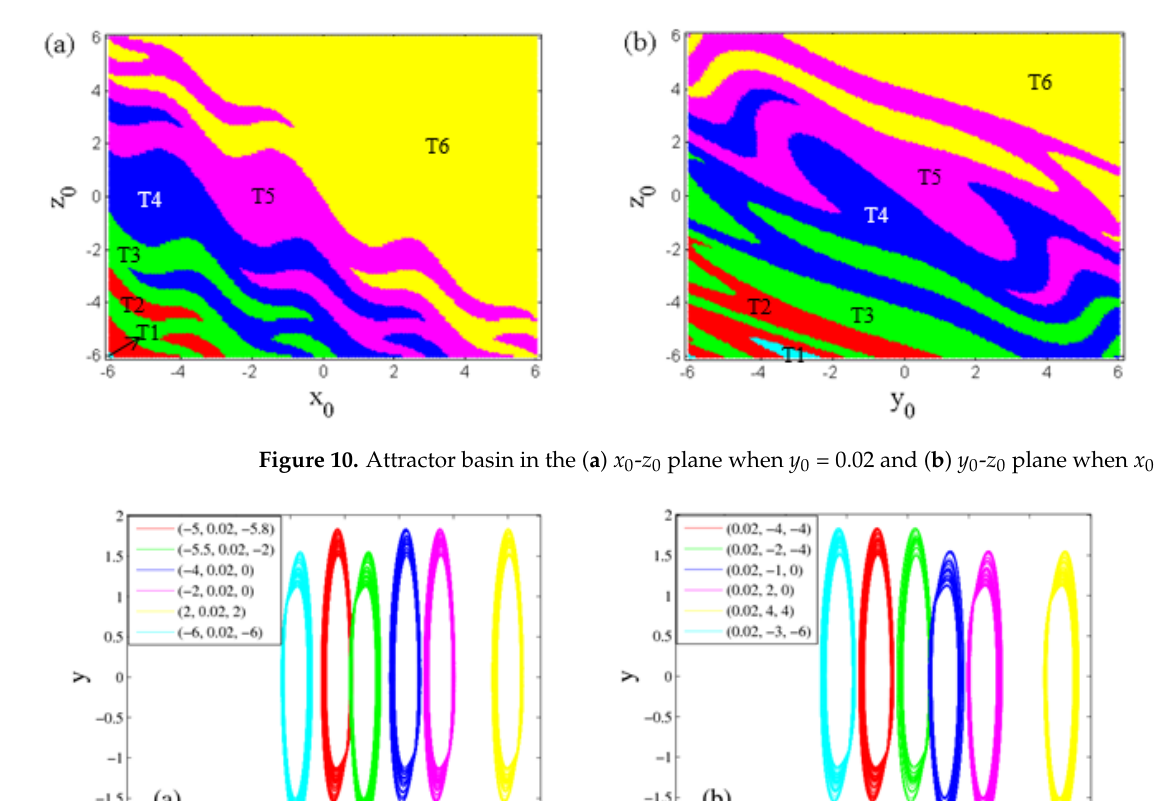
8 of 12 Figure 8. ( a ) Bifurcation diagram and ( b ) Lyapunov exponent spectra versus initial value y 0 , when a = 1.5, b = 0.6, c = 1.0, d = 2, x 0 = 0.1, z 0 = 0.1. Figure 9. ( a ) Bifurcation diagram and ( b ) Lyapunov exponent spectra versus initial value z 0 , when a = 1.5, b = 0.6, c = 1.0, d = 2, x 0 = 0.1, y 0 = 0.01. The attractor basin of the dynamical system is a set of initial states that result in a long-time motion close to the desired attractor. In other words, the qualitative behavior of the long-term motion of a given system may be fundamentally different according to the domain of the attraction to which the initial condition belongs. The attractors of different basins can be fixed points, limiting the cycles of various periods, quasi-periodic, chaotic, or hyperchaotic orbits. Therefore, the attractor basin can provide more detailed infor- mation about the multi-steady state of the dynamical system. Figure 10 shows the attractor basin of the system in the x 0 - z 0 plane with y 0 = 0.02 and the attractor basin of the system in the y 0 - z 0 plane with x 0 = 0.02, when the parameter condition a = 1.5, b = 0.6, c = 1.0, d = 2 and the sampling number 120 × 120 in the plane of the initial condition are considered. It can be seen from Figure 9 that under the considered parameters and initial conditions, the attractor basin has six different color domains, indicating that the system has six different types of attractors (respectively, named as T1, T2, T3, T4, T5, and T6). Figure 11a,b display the phase diagrams based on the initial conditions corresponding to different color re- gions in Figure 10a,b. It can be seen that under the initial conditions corresponding to